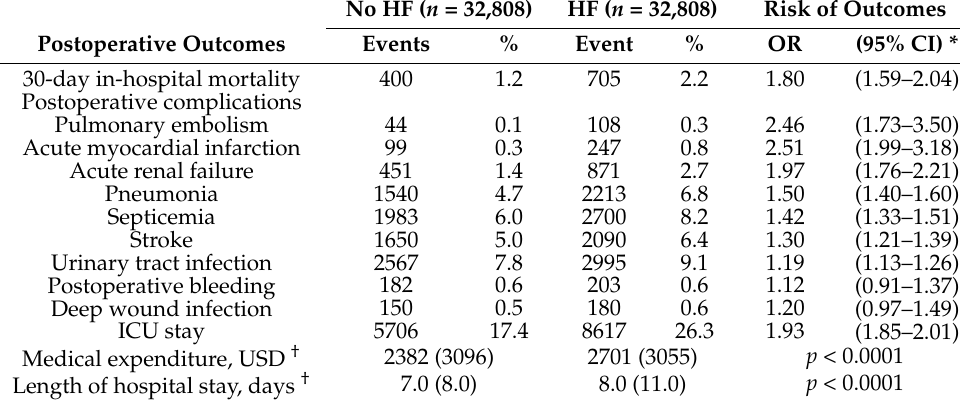
Table 2. Postoperative complications, mortality, and medical consumptions in patients with heart failure.